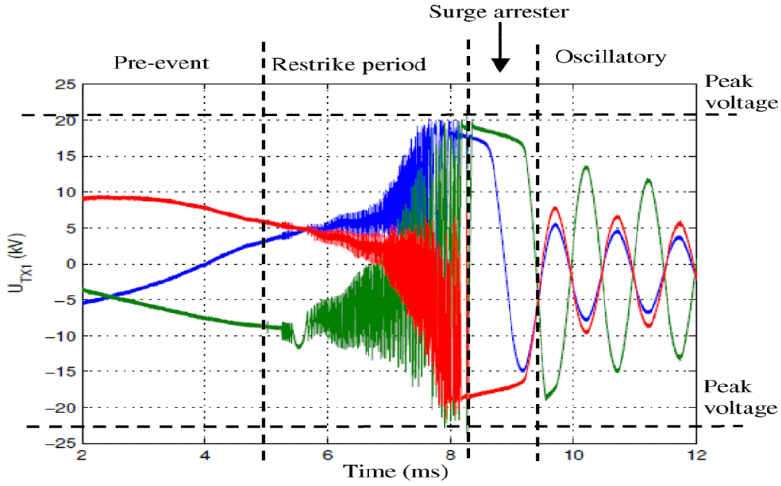
Figure 9. Example of measurement results illustrating various regime times of the transient waveform